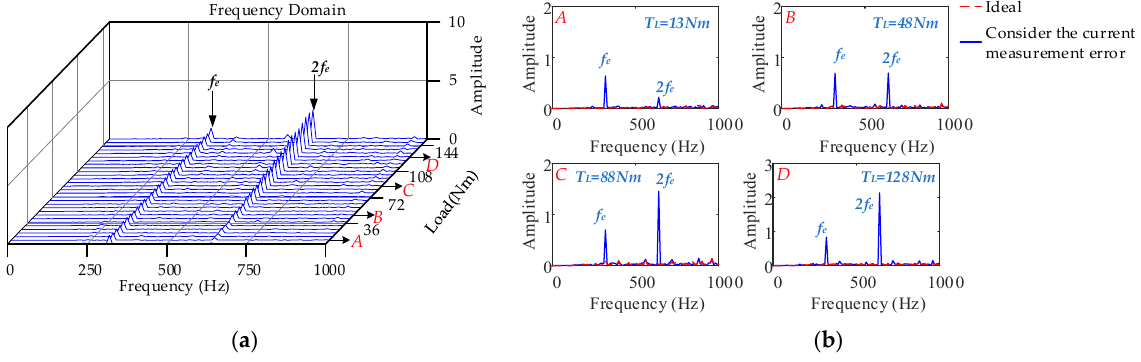
Figure 23. Frequency domain results of electromagnetic torque under different loads: ( a ) waterfall diagram of electromagnetic torque; ( b ) comparison results of electromagnetic torque.